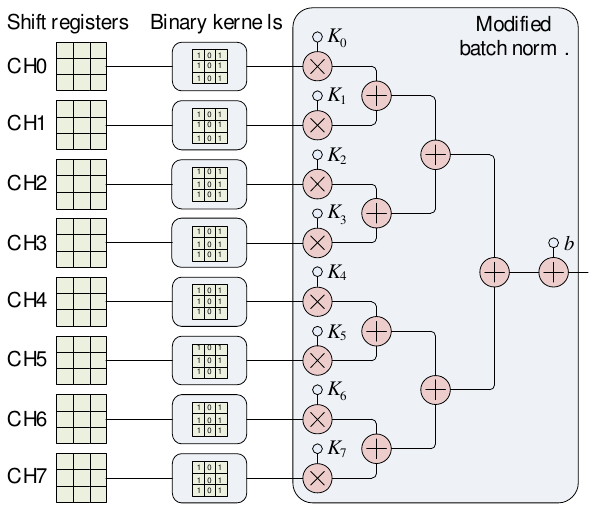
Figure 9. The 8-channel binary convolution and modified batch normalization block.